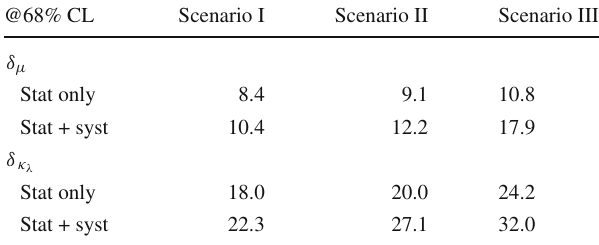
Table 6 Expected precision at 68% CL on the di-Higgs production cross-section and Higgs self coupling using the b ¯ bb ¯ b channel at the